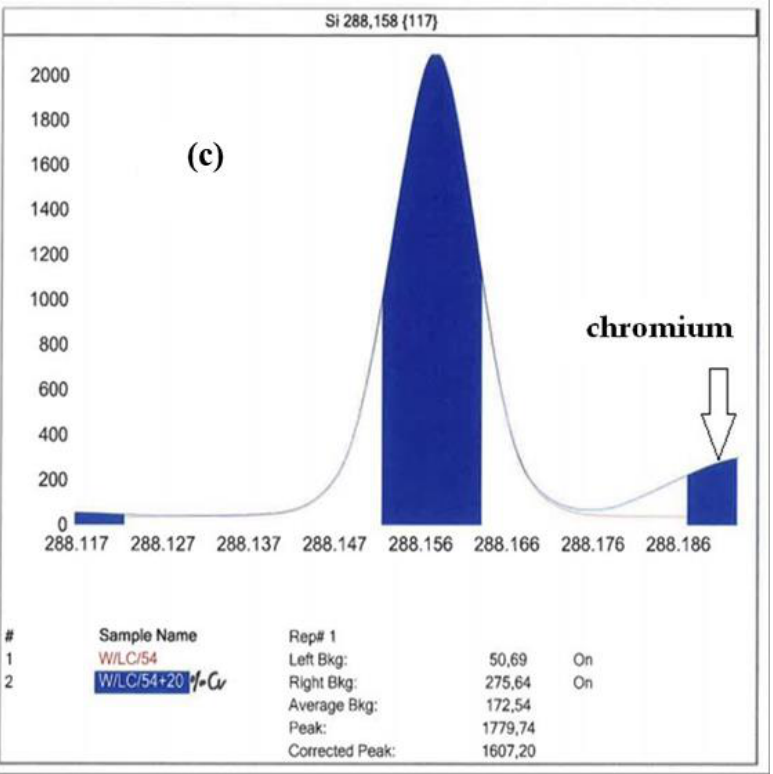
Figure 1. Silicon peak for CRM4 with the addition of 20% ( a ) molybdenum, ( b ) vanadium and ( c ) chromium .